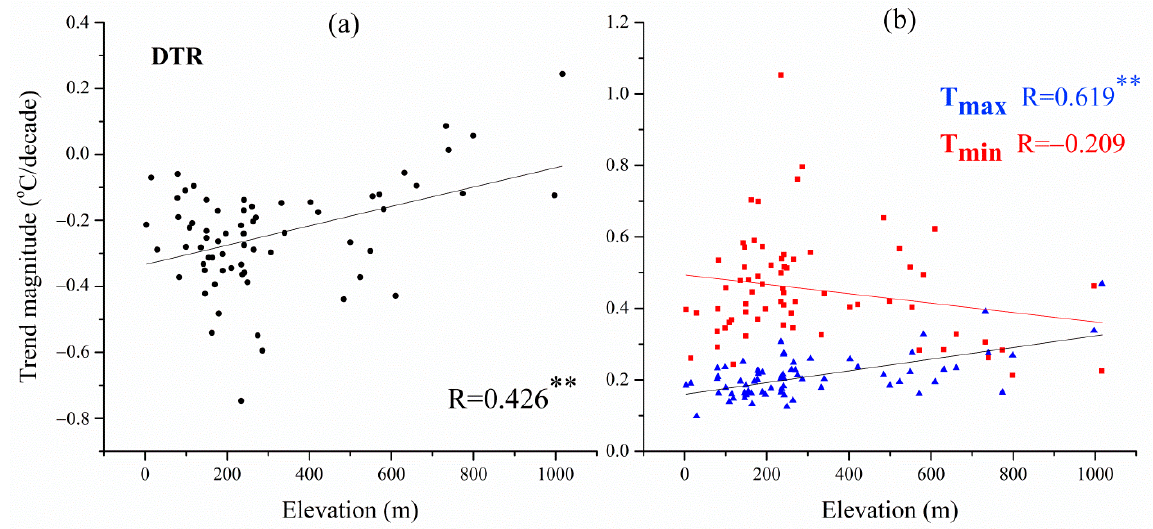
Figure 4. The relationship between elevation and ( a ) annual DTR, ( b ) annual T max , and ( b ) annual T min trends in the northeast China during 1961–2015. * Significant at p < 0.05, ** Significant at p < 0.01